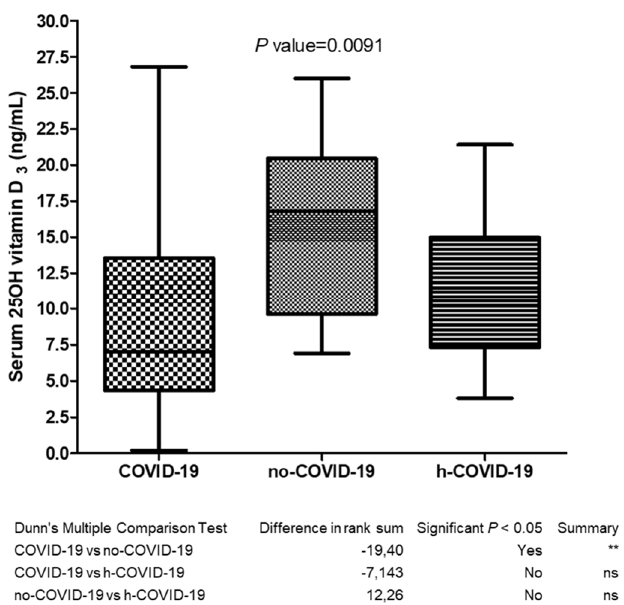
Figure 1. Serum 25(OH) vitamin D3 determination in COVID-19 (Group 1), no-COVID-19 (Group 2) and h-COVID (Group 3); ns = not significant, ** p value = 0.0091 When we stratified the data by gender, we observed no difference in the male population, with a range of 25(OH)D 3 serum levels of 10.4 ± 7.3 ng/mL in COVID-19 patients; 11.8 ± 4.3 ng/mL in no-COVID-19; and 11.7 ± 5.3 ng/mL in h-COVID-19 (Figure 2A).